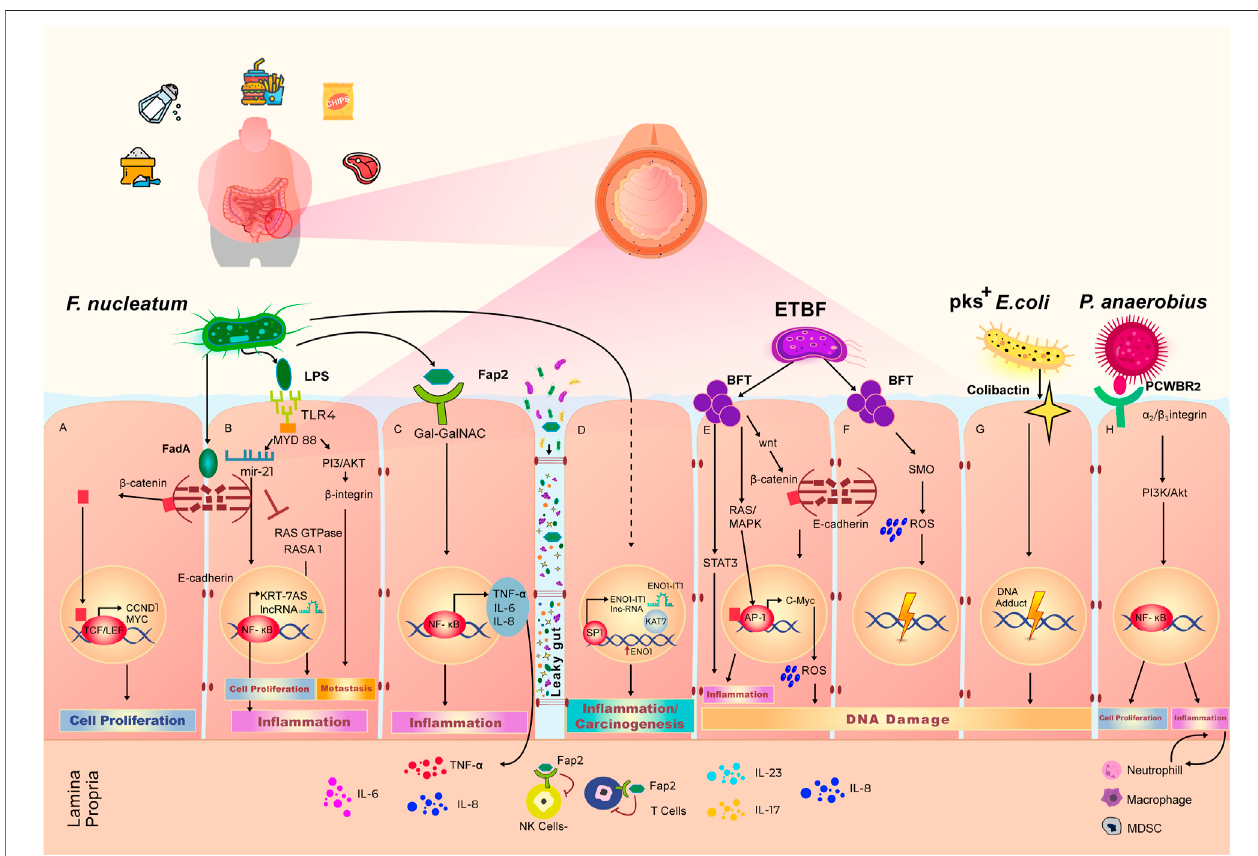
FIGURE 2 | Effect of Western diet on the gut microbiome and local pro-carcinogenic pathways. Adherence to Western diet results in the high abundance of Fusobacterium nucleatum , Enterotoxigenic Bacteroides fragilis (ETBF), pks + Escherichia coli and Peptostreptococcus anaerobius . Overpopulation of these bacteria in the gut microbiome leads to the increased cell proliferation, elevated grade of in fl ammation and accumulation of DNA damage, eventually resulting in an environment favorable to initiation or progression of colorectal cancer. (A) F. nucleatum secretes FadA toxin, which binds the E-cadherin complex on the wall of intestinal epithelialcells.UponinteractionwithFadA,E-cadherinundergoesphosphorylation,whichleadtocleavageandsubsequenttranslocationofthe β -Catenincomponentof the complextothenucleus. β -Catenin bindswithTCF/LEFtranscriptioncomplex,triggering theexpression ofCCND1 and MYC, thatgoverncellproliferation. (B) LPSis a polysaccharide on the cell wall of F. nucleatum , that binds the TLR4 receptor which are expressed on the intestinal epithelial cell membrane. LPS-TLR4 complex activates MYD88 adaptor that results in inhibition of a Ras GTPase — RASA1. The inhibition of RASA1 leads to unwanted cell proliferation. LPS-TLR4-MYD88 complex alsoinducestheproductionofmicroRNAmiR21,thatinturnactivatesNF- κ Btranscriptionfactorandleadstotheproductionofpro-in fl ammatoryagentsincludingKRT- 7AS long non-coding RNA. (C) Upon binding of microbial protein Fap2 with cell membrane receptor, surface expressed polysaccharide Gal-Gal-NAc modulates the activation of NF- κ B transcription factor that leads to the increase in intestinal in fl ammation through the production of TNF- α , IL-6, and IL-8. Increased intestinal permeability also, known as “ Leaky gut ” phenomena, allows the bi-directional passage of bacteria and their metabolites, as well as immune in fl ammatory agents. Through the leaky gut, Fap2 is able to reach lamina propria and diminish the activity of Natural killer (NK) cells and T cells. (D) F. nucleatum interacts with intestinal epithelial cells to stimulate the production of long non-coding RNA (lncRNA) ENO1-IT1 via SP1 transcription factor. Production of ENO1-IT1 increases concurrently the expression of ENO1. This cascade of reactions leads to the increased level of carcinogenesis and in fl ammation. (E) ETBF produces BFT toxin, that interacts with epithelial cells to trigger intestinal in fl ammation via activation of STAT3 signaling pathway. BFT activates RAS/MAPK pathways to further initiate AP1 and start the production of IL-8 resulting in intestinal in fl ammation. BFT stimulates the translocation of β -Catenin to the nucleus initiating expression of C-Myc and production of reactiveoxygenspecies(ROS),leadingtoDNAdamage. (F) BFTalsoinducetheproductionofspermineoxidase(SMO)andSMO-dependentROSproduction,resulting inDNAdamage. (G) Colibactinissecretedbyofpks + E.coli .InteractionofcolibactinwithepithelialcellsresultsinaccumulationofDNAadductsandfurtherDNAdamage. (H) P.anaerobius surfaceproteinPCWBR2bindsto α 2 / β 1 integrinontheepithelialcellstoinitiatecellproliferationviaactivationofPI3K/Aktsignalingpathway andNF- κ B transcription factor. This interaction also leads to expansion of neutrophils, macrophages and myeloid derived suppressor cells driving chronic in fl ammation and tumor